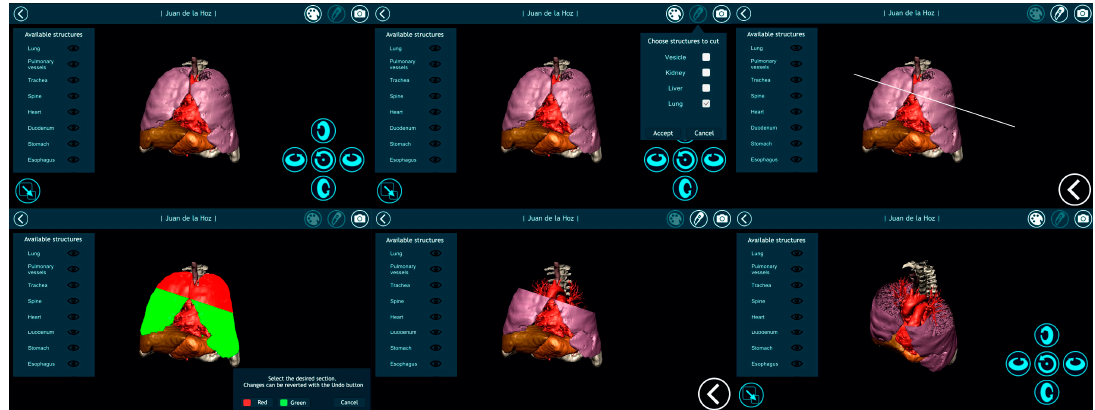
Figure 19. Visualization platform with a cutting sequence for the different anatomical regions of a patient.